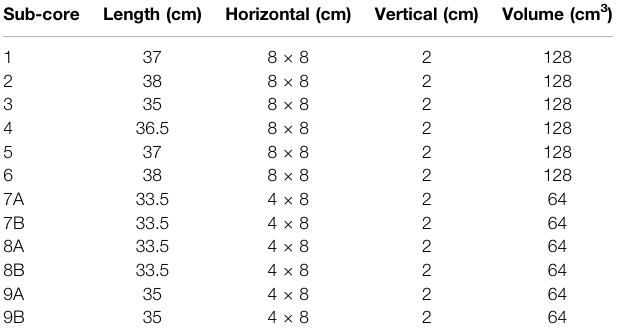
TABLE 1 | Overview of different parameters from the sub-cores 1 to 9: lengths of theindividualsub-cores,themeasuredhorizontalandverticalsamplesizeand the resulting volume for each large-volume bulk